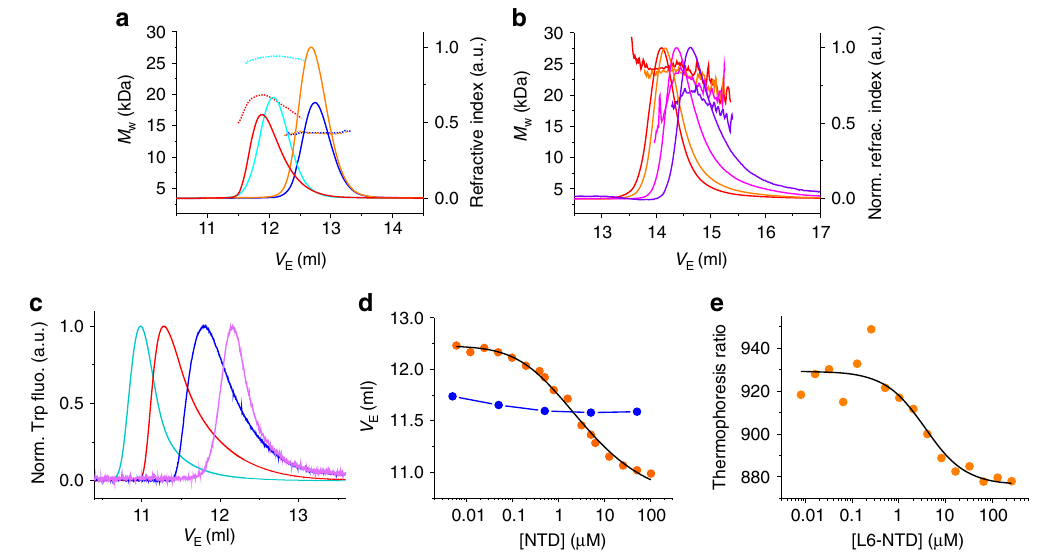
Fig. 3 NTD dimerization assays. a SEC-MALS of L6-NTD and WT-NTD. SEC elution bands (solid lines) and corresponding average values of M w (broken lines) measured by MALS are shown. L6-NTD and WT-NTD measured at pH 7.0 (200 mM ionic strength) are shown in orange and blue. L6-NTD and WT- NTD measured at pH 6.0 (60 mM ionic strength) are shown in red and cyan. b SEC-MALS of 12 µ M (red), 4 µ M (orange), 1.2 µ M (magenta), and 0.4 µ M (blue) L6-NTD measured at pH 6.0 (8 mM ionic strength). Signals of elution bands are normalized to peak intensities. c High-resolution SEC of 100 µ M (cyan), 6 µ M (red), 0.8 µ M (blue), and 0.05 µ M (violet) L6-NTD measured using Trp fl uorescence detection. Signals of elution bands are normalized to peak intensities. d V E of L6-NTD (orange) and WT-NTD (blue) measured at pH 6.0 (20 mM ionic strength) and at various protein concentrations using a high-resolution SEC. The black line is a fi t to the data using a thermodynamic model for a monomer/dimer equilibrium. e Thermophoresis ratio of fl uorescently modi fi ed L6-NTD-Q50C in presence of increasing concentration of L6-NTD (orange). The black line is a fi t using a model for a binding isotherm. Differences in absolute peak values of V E of elution bands shown in panels ( a – c ) originate from the different SEC columns used in these experiments. Source data are provided as Source Data fi